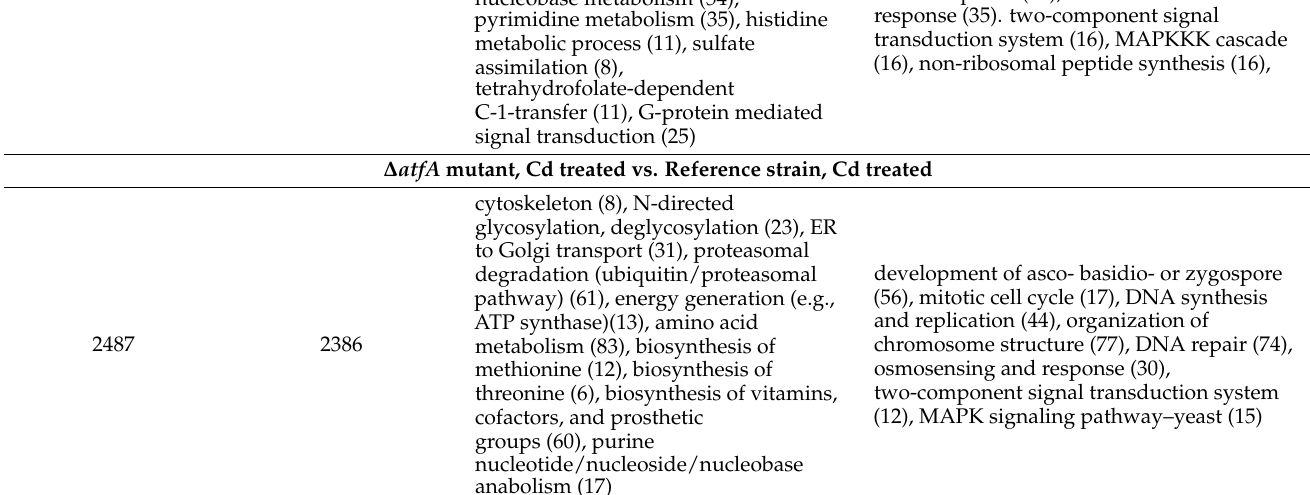
a —Table contains selected FunCat, GO and KEGG pathway terms significantly enriched in the up-regulated and down-regulated gene sets. The complete list of all the significantly enriched terms is available in Table S4. Figures presented in parenthesis after the terms represent the number of up-regulated or down-regulated genes belonging to the appropriate term in the particular